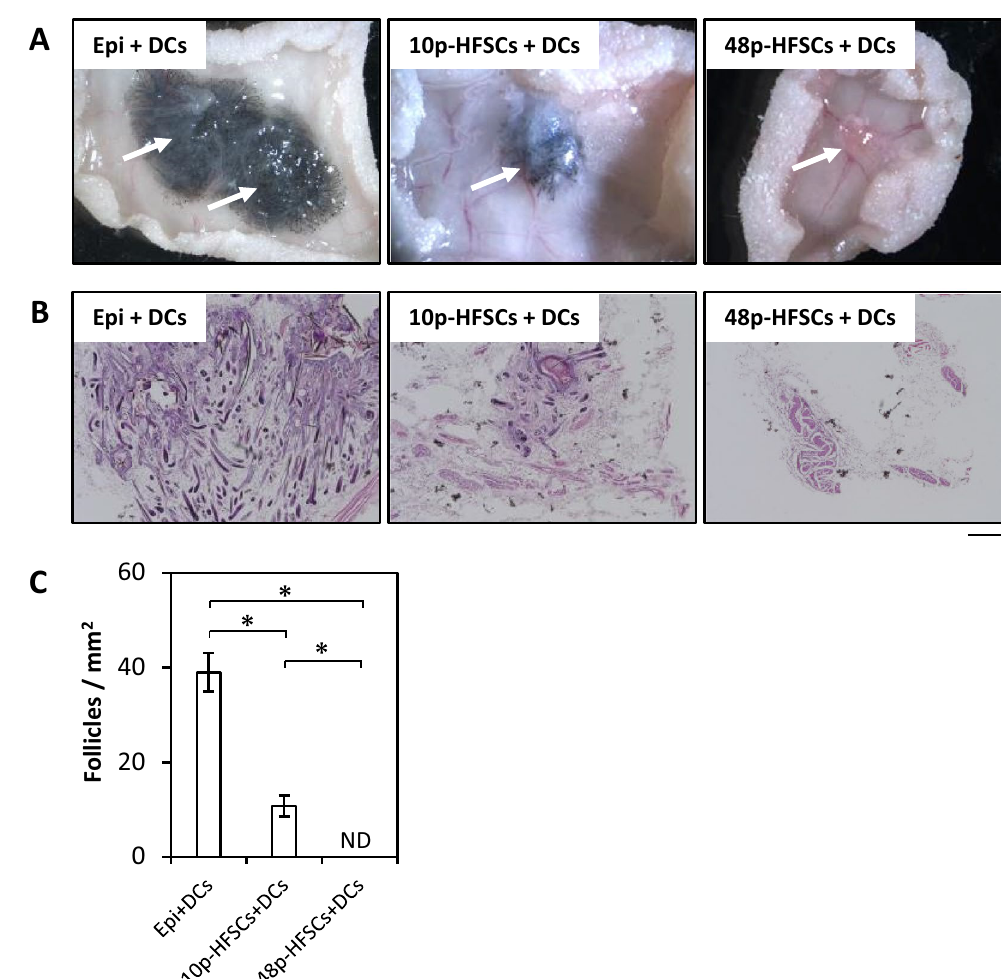
Figure 6. Hair follicle-inducing ability of HFSCs lost during long-term culture with M-CnT. ( A ) Results of in vivo patch assays using epidermal cells (Epi) as controls, 10p- and 48p-HFSCs passaged with M-CnT, and dermal cells (DCs) prepared from PD2 mice (Epi/DCs, 10p-HFSCs + DCs, 48p-HFSCs + DCs, respectively). ( B ) Analysis of reconstituted follicle tissues. Large numbers of hair follicles were detected in transplants of Epi or 10p-HFSCs cultured with M-CnT in combination with DCs (Epi/DCs, 10p-HFSCs + DCs, respectively), whereas that was not seen in 48p-HFSCs cultured with DCs (48p-HFSCs + DCs). Scale bar = 200 mm. ( C ) Number of mature hair follicles per mm 2 in reconstituted skin. ND; not detectable. * p <